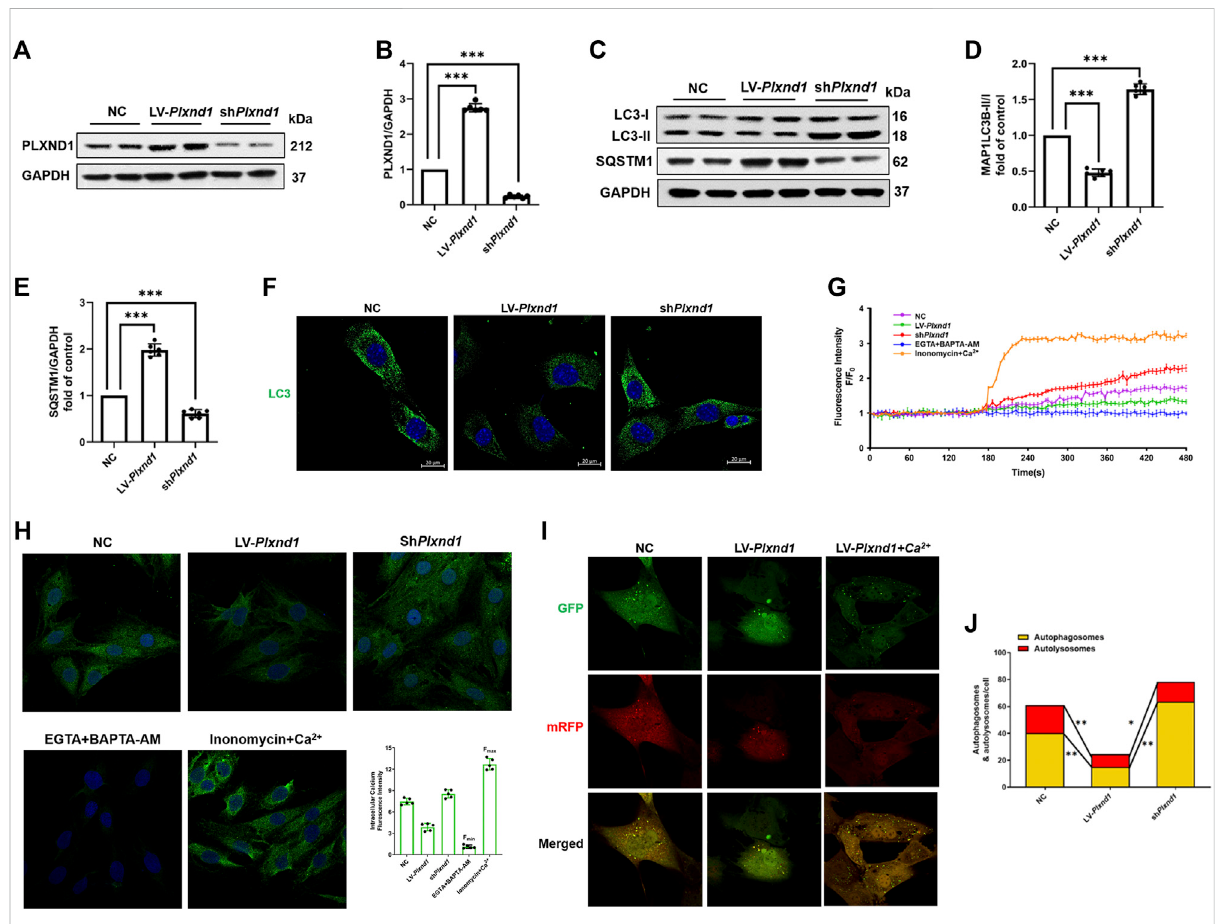
FIGURE 3 PLXND1 inhibits autophagy via intracellular calcium signaling. Mouse EECs were treated with NC, LV- Plxnd1 , and sh Plxnd1 . (A) Representative WBofPLXND1inEECssubjectedtotheindicatedtreatments. (B) Quantitativeanalysisoftheef fi cacyofoverexpressionandknockdownof Plxnd1 . (C) Representative western blots of autophagic markers in EECs subjected to the indicated treatments. (D – E) Quantitative analysis indicates that PLXND1 signi fi cantly affects the level of autophagy. (F) Immuno fl uorescence staining was used to detect MAP1LC3B in EECs. Scale bar: 20 μ m. (G) IntracellularcalciumwasmarkedbytheFluo-3-AMprobeandmeasuredcontinuouslyfor8 min (H) EECswereincubatedwiththecalciumprobe Fluo-3-AM.EGTA + BAPTA-AM was used to obtain theminimum fl uorescence intensity (F min ),whereas ionomycin + calcium wasused to obtain the maximum fl uorescence intensity (F max ). Scale bar: 20 μ m. Quantitative analysis showed the fl uorescence intensity in the different groups. (I-J) EECs were infected with a tandem GFP-mRFP-LC3 adenovirus for 24 h. Representative merged images (I) and quantitative analysis (J) of yellow and